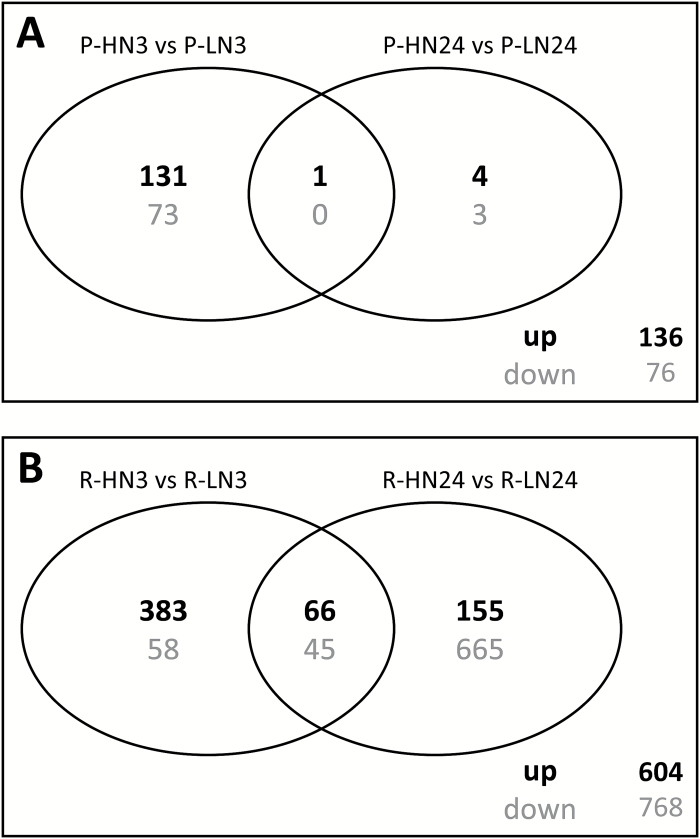
Analysis of the differentially expressed genes (DEGs) in roots in response to heterogeneous N availability in the two scion/rootstock combinations. Venn diagrams show the number of transcripts that were up-regulated (bold) and down-regulated (grey) in HN roots compared with LN roots at 3 and 24 hpt in (A) CS/1103P plants and (B) CS/RGM plants. In (B), in addition to the 1369 contigs that were differentially expressed, three contigs were duplicated since they followed a different regulation pattern (i.e. up- or down-regulated) between 3 and 24 hpt.